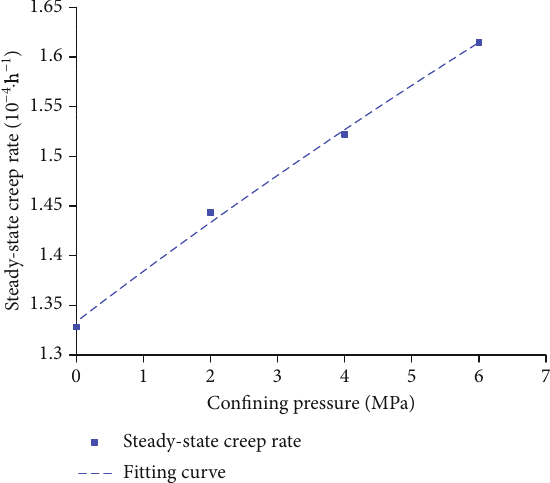
Figure 18: Curve of the steady-state creep rate versus the con fi ning pressure at the fourth loading stress level after 9 freeze-thaw